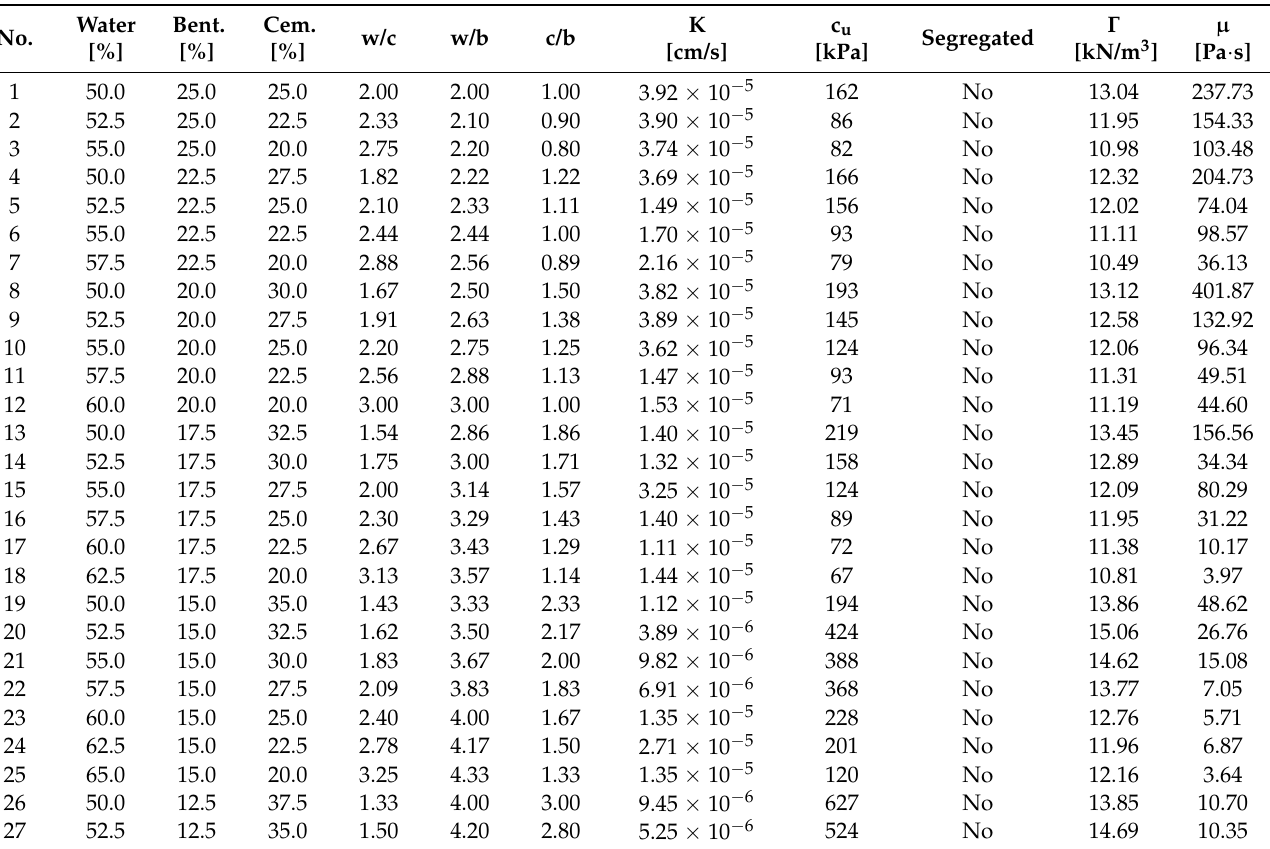
Table 3. Test data